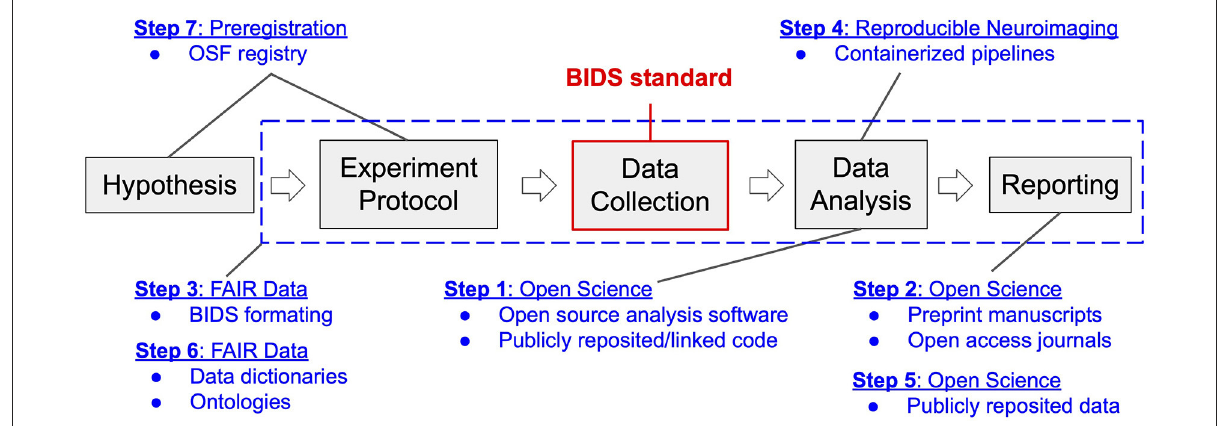
FIGURE1 Neuroimaging workflow in the Brain Imaging Research Center in the context of transition to open and reproducible science best practices. Gray blocks represent the key steps in the workflow of a typical neuroimaging experiment, from inception to reporting. Blue text and dashed box indicate components of the four categories of open and reproducible best practices that map onto this workflow. Modules of transition (1–7) are reported according to the order (stepwise) of their implementation. The BIDS standard, highlighted in red, denotes the data structure around which the four categories of best practices